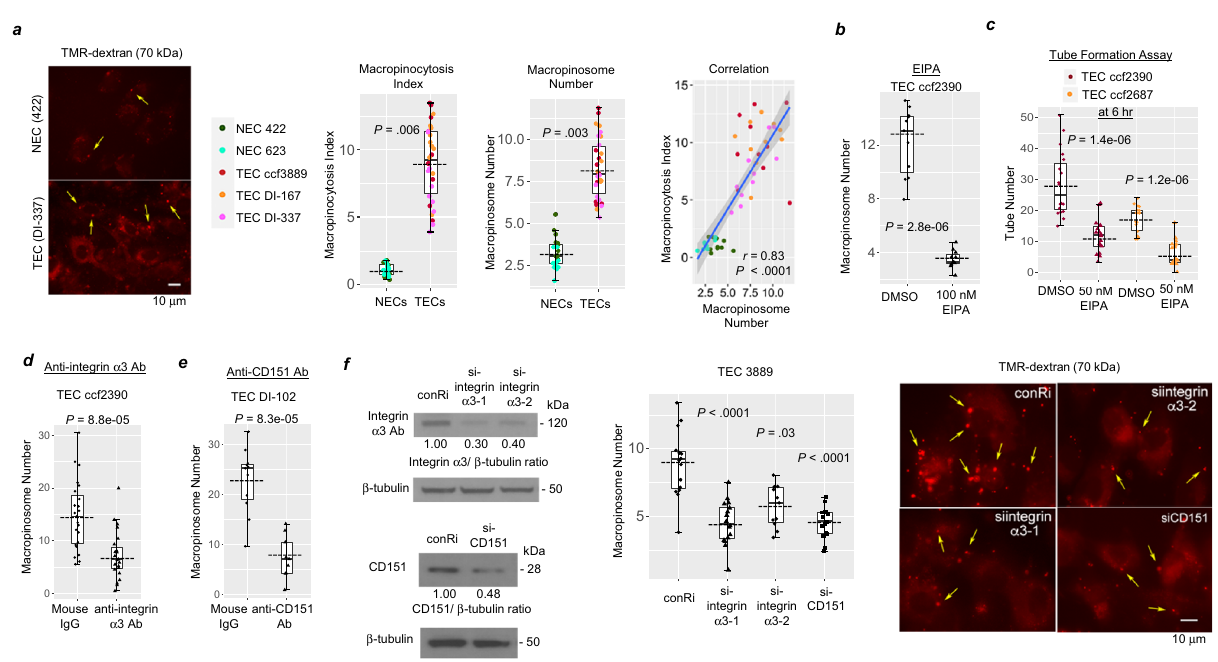
Fig. 5 Macropinocytosis promoted by integrin α 3 β 1/CD151 is higher in TECs and inhibition of macropinocytosis reduces tube formation. a NECs (422 and 623) and TECs (isolates ccf3889, DI-167, and DI-337) were incubated with 25 µ g/ml TMR-dex for 30min, followed by imaging. n denotes the number of different fi elds: NECs, n = 20 for 422 and n = 20 for 623; and TECs, n = 30 for each isolate. Representative images are shown. Macropinocytosis Index was de fi ned as (total TMR-dex area/total cell area)x 100 per fi eld and Macropinosome Number was de fi ned as the average number of macropinosomes in a cell per fi eld. Statistical analysis: two-sided Wilcoxon-rank-sum tests. Correlation between Macropinocytosis Index and Macropinosome Number was analyzed by linearregression model after adjustingfor groupeffect;shaded areain the correlation graph representsthe95%con fi dence bandfor the regressionline. b TECs (isolate ccf2390) treated with DMSO (vehicle-control; n = 11) or 100nM EIPA ( n = 11) for 10min were subsequently incubated with TMR-dex for 30min, followed by imaging. Statistical analysis: two-sided Wilcoxon-rank-sum test. c Tube formation of TECs (isolates cf2390 and ccf2687) was quantitated by the numbers of tubes formed per fi eld on Matrigel after 6 h in M199 + 10% FBS in the presence of DMSO (vehicle-control; n = 18 for ccf2390, and n = 18